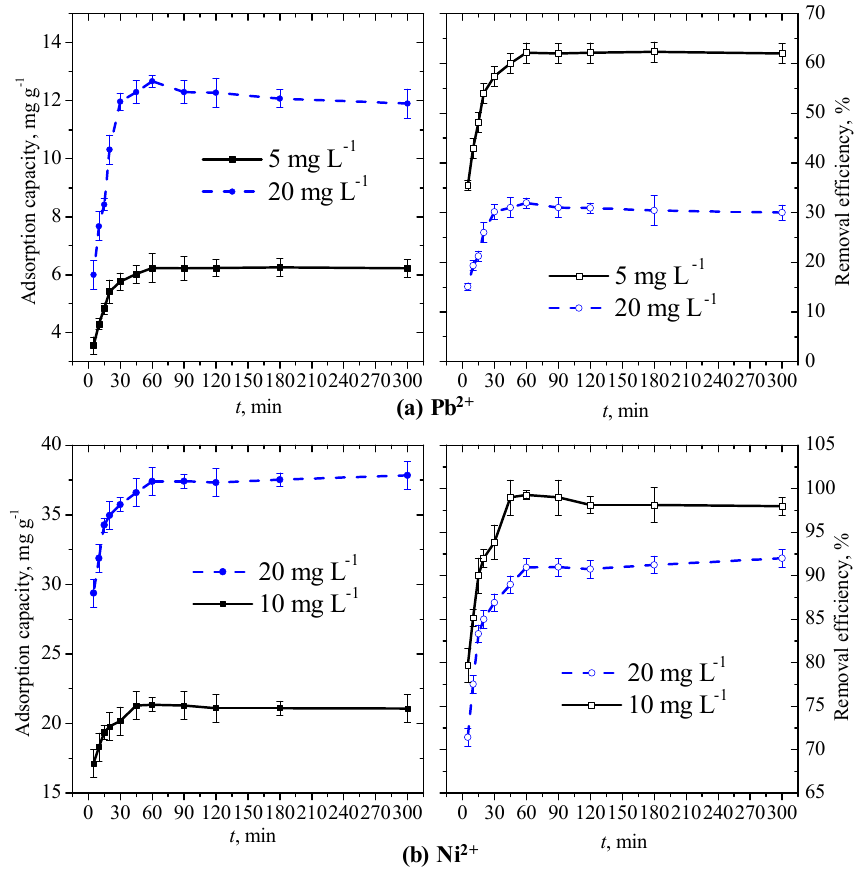
Figure 3. Variations with time of the adsorption capacity and removal efficiency of ( a ) Pb 2+ and ( b ) Ni 2+ by